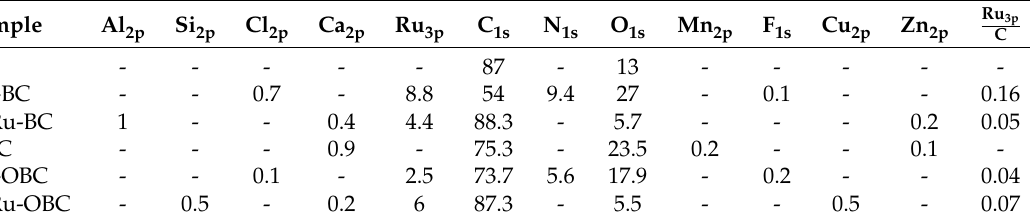
Table 6. The Results of XPS Survey (Atomic Percentages).